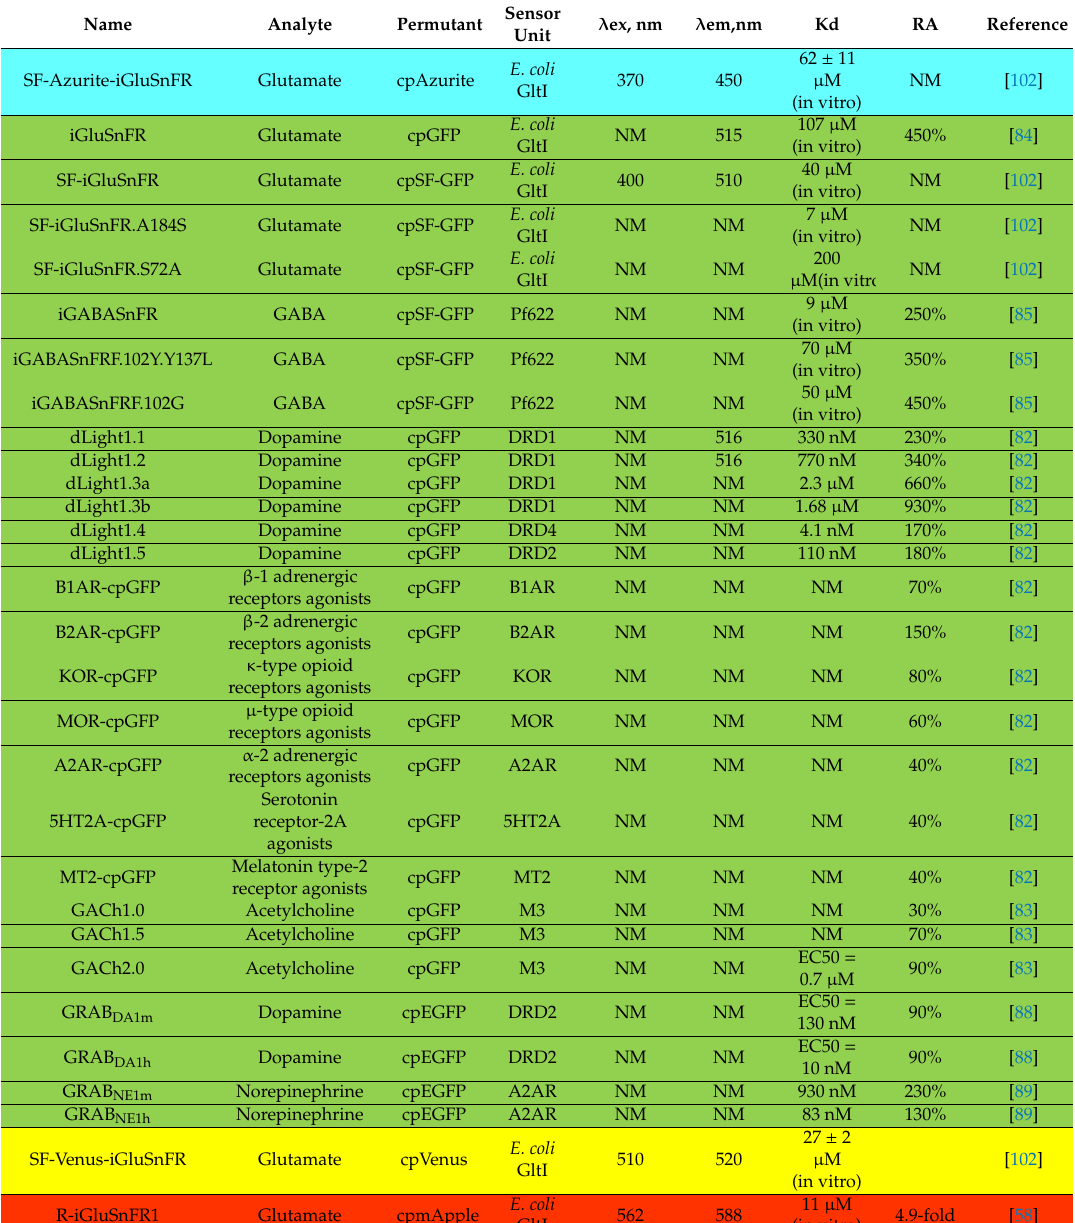
Table 8. GEFIs for neurotransmitters